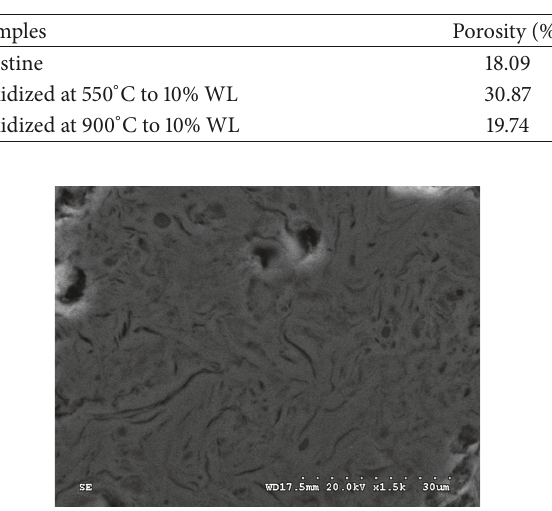
Figure 5: SEM image of pristine A3-3 MG at 1500x Mag.